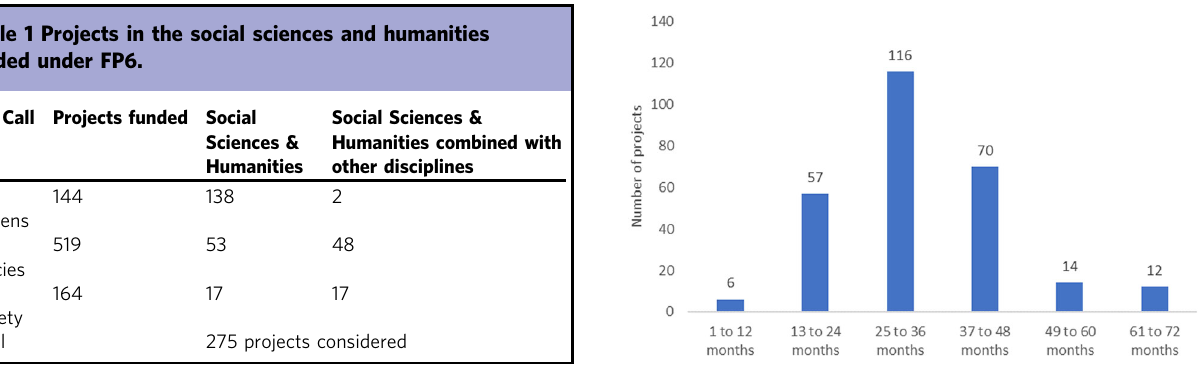
Fig. 3 Length of projects. Length of projects in the Social Sciences and Humanities funded under